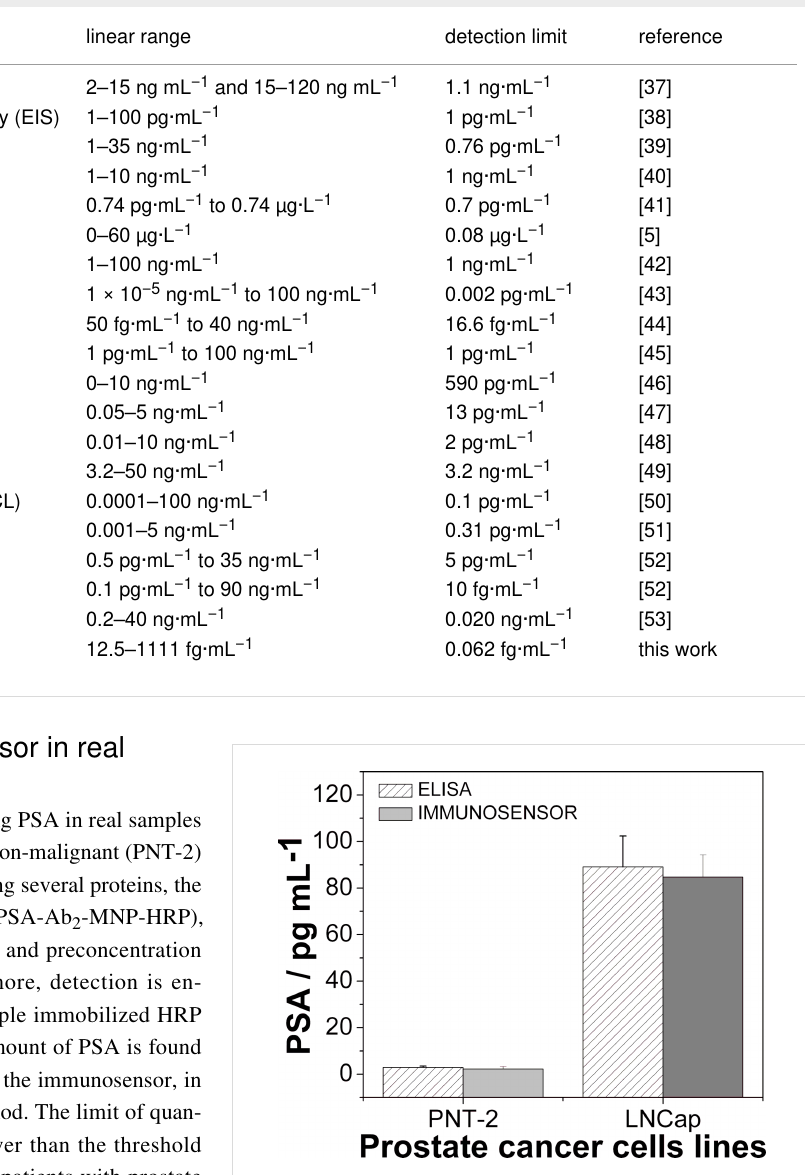
Figure 3: ELISA and IN μ -SPCE results for PSA in control cell lysates (PNT-2) and prostate cancer cells